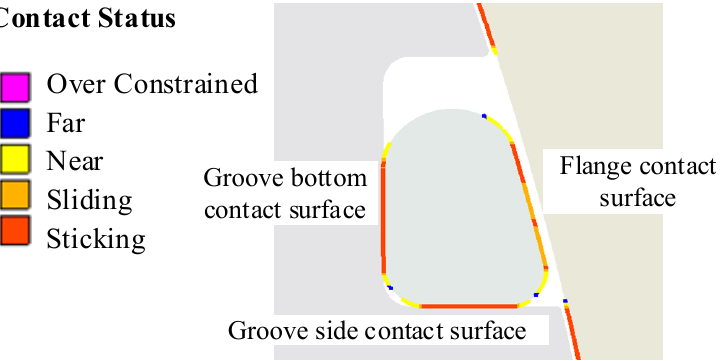
Figure 14. Schematic diagram of contact surface. As shown in Figure 15, the contact width of the O-ring increases as the pressure of the external fluid medium increases, however, the contact width of the three contact surfaces grows differently. The growth of the flange contact surface is the smallest, and the growth rate of the contact width in the interval from 0 to 5 MPa is significantly larger than that in the interval from 5 to 60 MPa. This is because the flange contact surface is the main sealing surface, and the contact width of the flange contact surface can be very large after the pre-compression of the flange on the O-ring. The contact surface on the side of the groove and the contact surface on the bottom of the groove are used as secondary sealing surfaces, and the contact width at the beginning is relatively small, however, with the increase of fluid medium pressure, the growth rate of the contact width of the two contact surfaces becomes larger, the growth rate is relatively small in the interval from 0 to 5 MPa, and the growth rate shows a smooth trend in the interval from 5 to 60 MPa. This is due to the large deformation of the compressed side of the O-ring under high pressure. This leads to a large contact pressure on the bottom and side contact surface of the groove, and with the increase in pressure, the increase of stress rate inside the O-ring will gradually level off and converge to the allowable stress value of the material. The width of the side and bottom contact surfaces of the groove are related to the internal stress of the